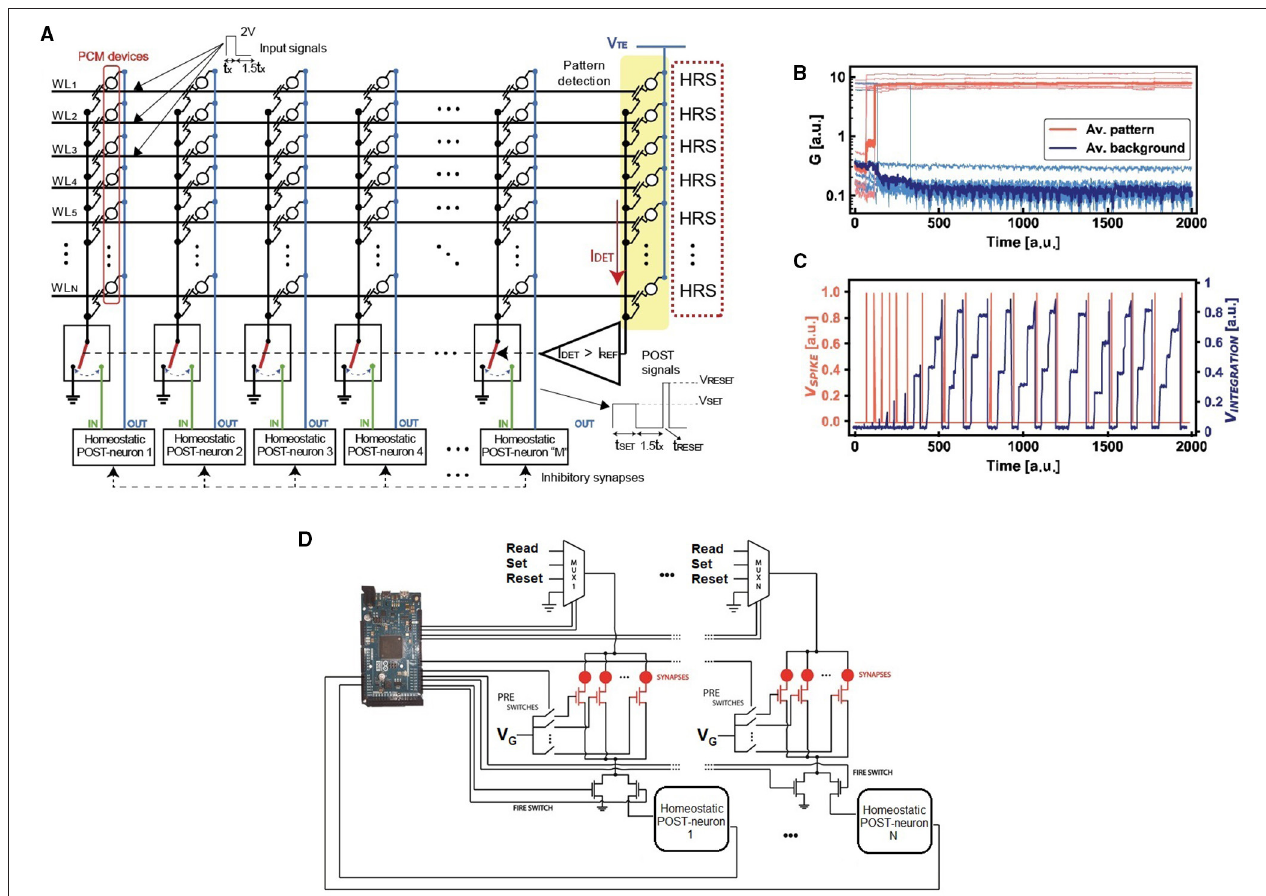
FIGURE 4 | (A) Experimental setup for the asynchronous STDP, where the inputs are submitted at the wordlines (WLs). Every column connects the WLs to a specific POST by using 1T1R PCM excitatory synapses, while the inhibitory synapses are implemented via discharge signals of the integrators. A further column of HRS devices is used for pattern/noise detection. The integration activity of each neuron is enabled only for I DET > I REF . (B) Experimental evolution of the pattern and background synapses under STDP. Note that the inputs are presented to the network asynchronously, since the potentiation and depression are gradual. (C) At every firing activity, the internal PCM device of the neuron is incrementally set thus obtaining an overall reduction of the spiking frequency due to the increase of the internal threshold of the neuron. This spike frequency adaptation enables optimized pattern specialization and reduced energy consumption. (D) Schematic representation of the experimental setup with several POST-synaptic neurons in order to implement a WTA network. Note that the microcontroller (we used both Arduino 2 and Arduino Mega2560) acts as master of the